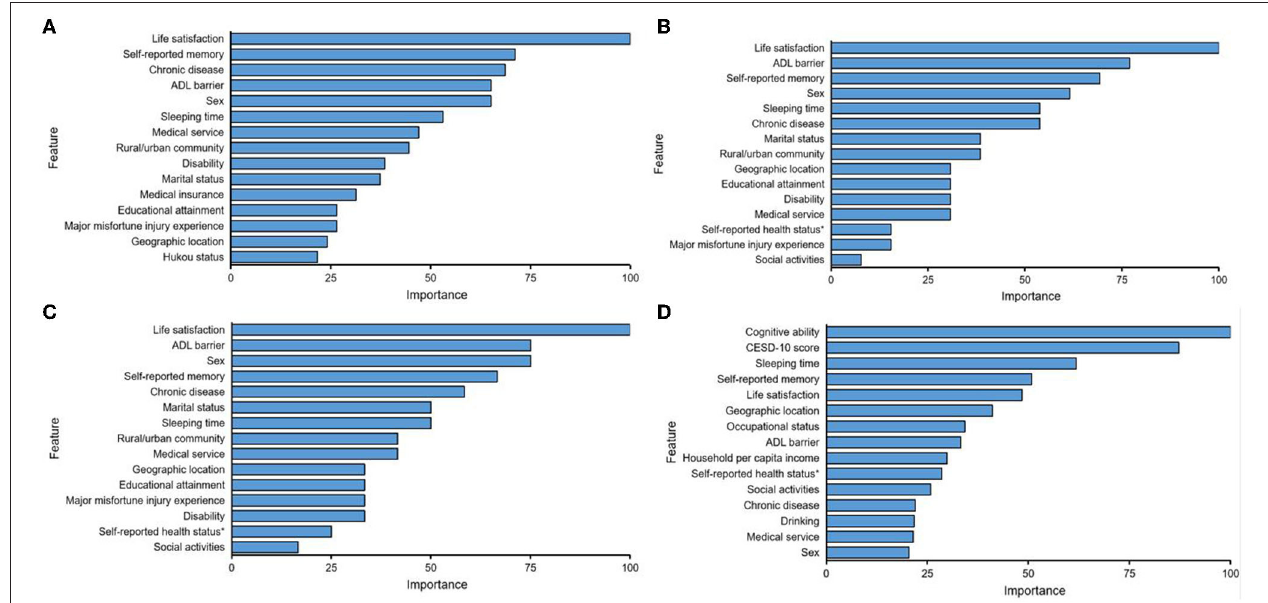
FIGURE 4 | Display of the top 15 predictor variables for predicting depression by using Logistic (A) , Lasso (B) , Ridge (C) , and Random forest (D) . Feature: predictor; Overall: 100 = most important; and 0 = least important. Self-reported health status*: Self-reported health status before 15 years